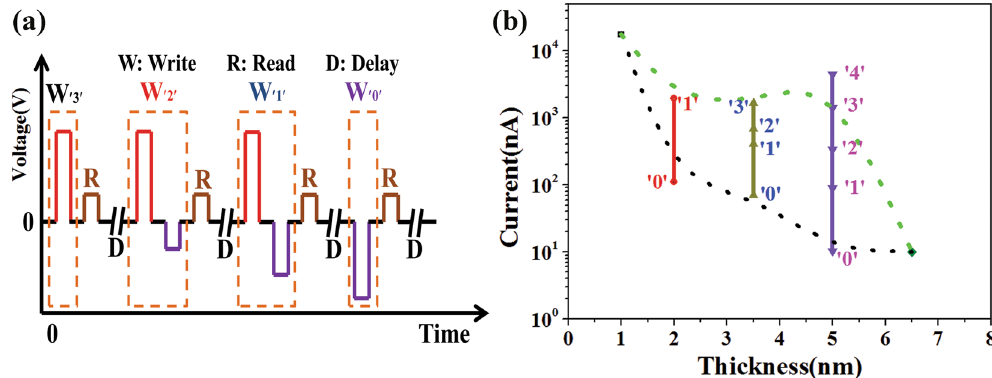
Figure 4. ( a ) The test processes. The voltage pulses applied in the test are about 5 μ s. Before writing the middle resistance states (like ‘1’ and ‘2’), a voltage pluse should be applied to set the device at lowest resistantce. ( b ) The current as a function of thickness, all RSs are read at 0.8 V.